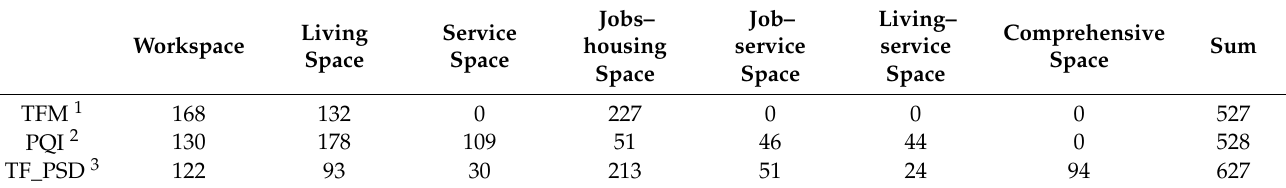
Figure 7. Recognition results of the travel flow model considering the spatial distribution of public facilities. public facilities. Table 6 . Comparison of the recognition results of the three methods. Table 6. Comparison of the recognition results of the three